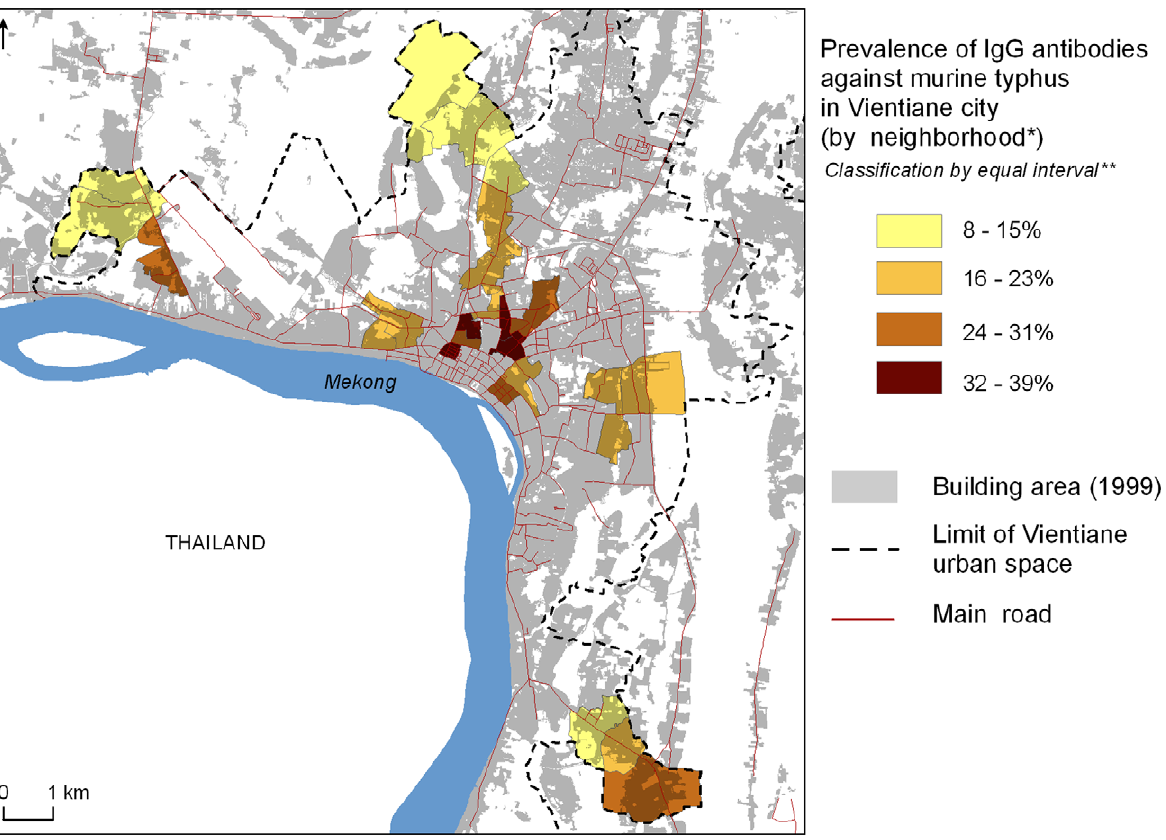
Figure 2. Spatial distribution of households with a member IgG positive against murine typhus in Vientiane city in 2006. * The « neighborhood » is the primary administrative unit in Laos and constituted the primary sampling unit of the seroprevalence survey within Vientiane. ** Equal Interval Classification method divides a set of attribute values into groups that contain an equal range of values. Note: Cartographic files from ‘‘Atlas Infographique de Vientiane’’[26].